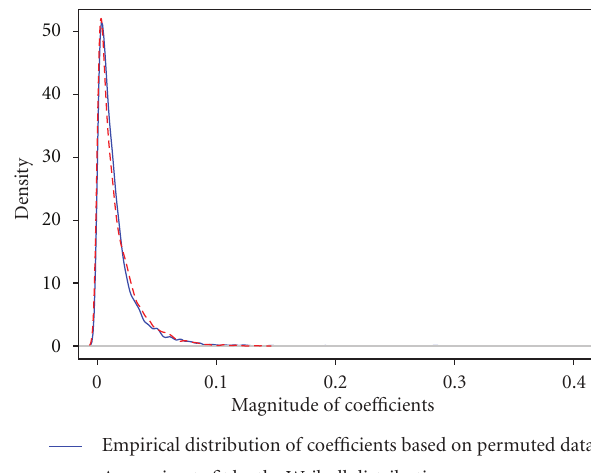
Figure 1: Probability density function of coe ffi cients (regulatory scores) based on permuted data and the approximated fit by the Weibull distribution. The solid line denotes the empirical probabil- ity density function of regression coe ffi cients obtained by Inferelat- or in the permuted expression data, while the dotted line denotes the probability density function of the Weibull distribution (6) with k = 0 . 889 and λ = 0 .